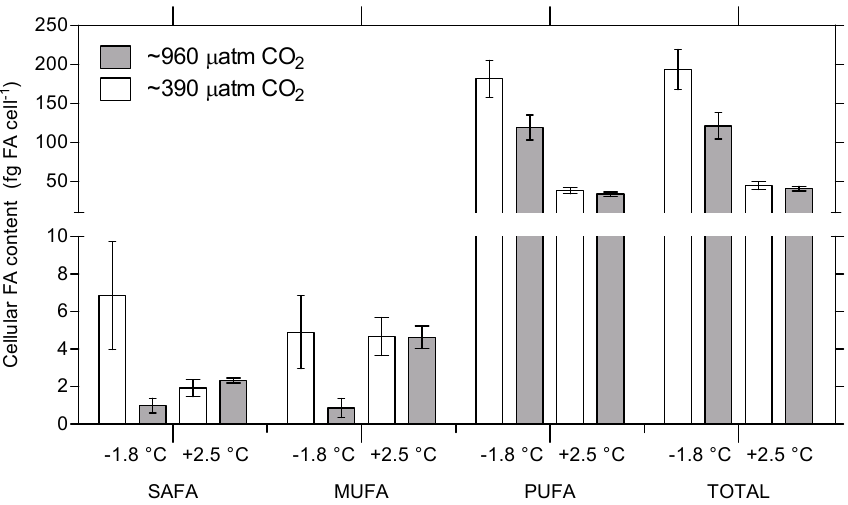
Fig. 4. Cellular fatty acid content (fg FA cell − 1 ) in N. lecointei after 14 days of treatment in Experiment A. SAFA = saturated fatty acids, MUFA = monounsaturated fatty acids, PUFA = polyunsaturated fatty acids. Error bars represent standard error ( n = 4). Table 1. Cellular content of acyl lipid fatty acid in N. lecointei after 14 days of treatment in Experiment A. Values within brackets represents standard error ( n =